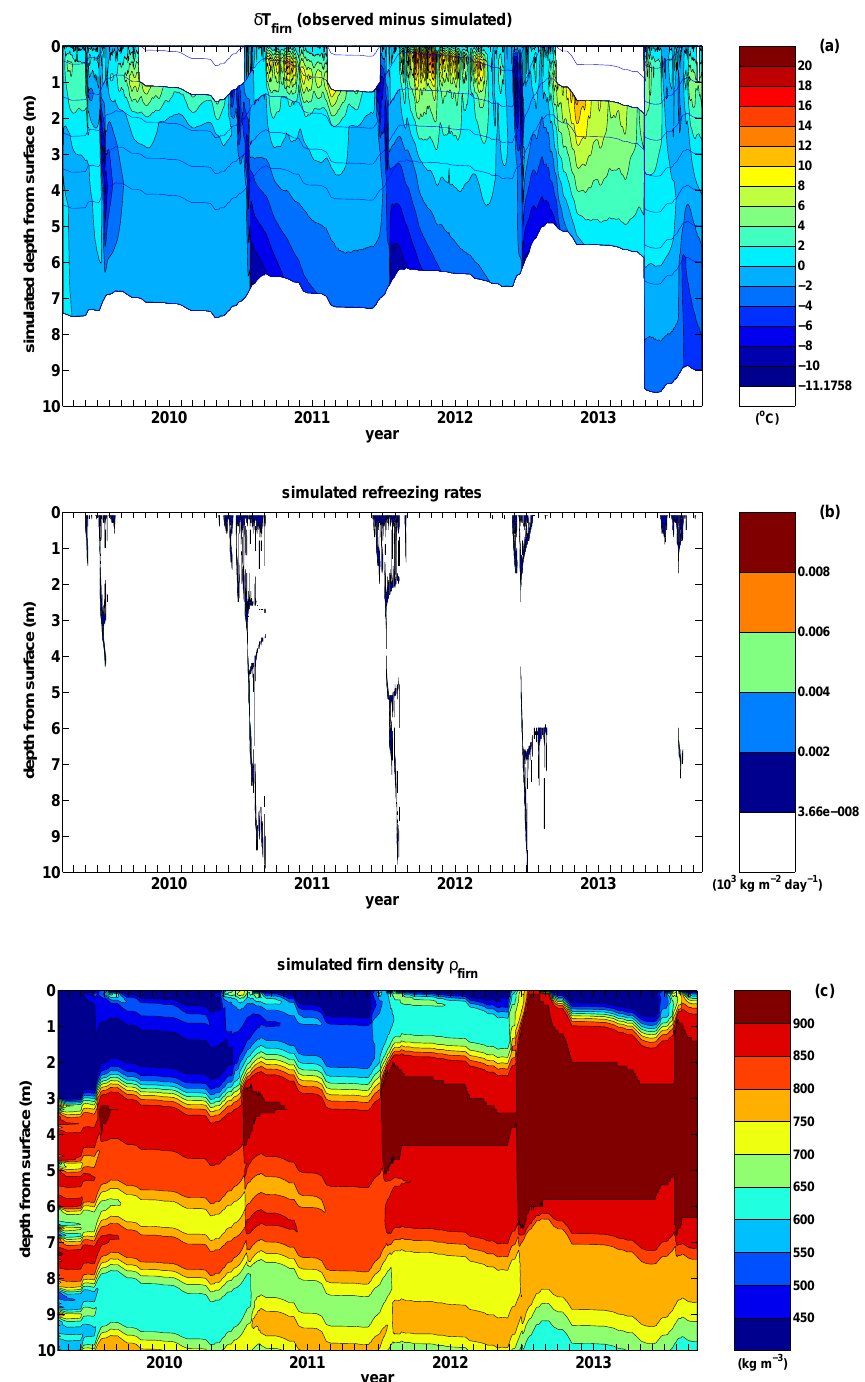
Figure 11. (a) Difference between firn temperature measured by the KAN_U thermistor string and simulated firn temperature. The blue lines indicate the position of the thermistors below the surface. The white areas near the surface are due to surfaced thermistors. Note that the thermistor string was replaced by a new one drilled on 28 April 2013. (b) Simulated refreezing rates. (c) Simulated firn density.